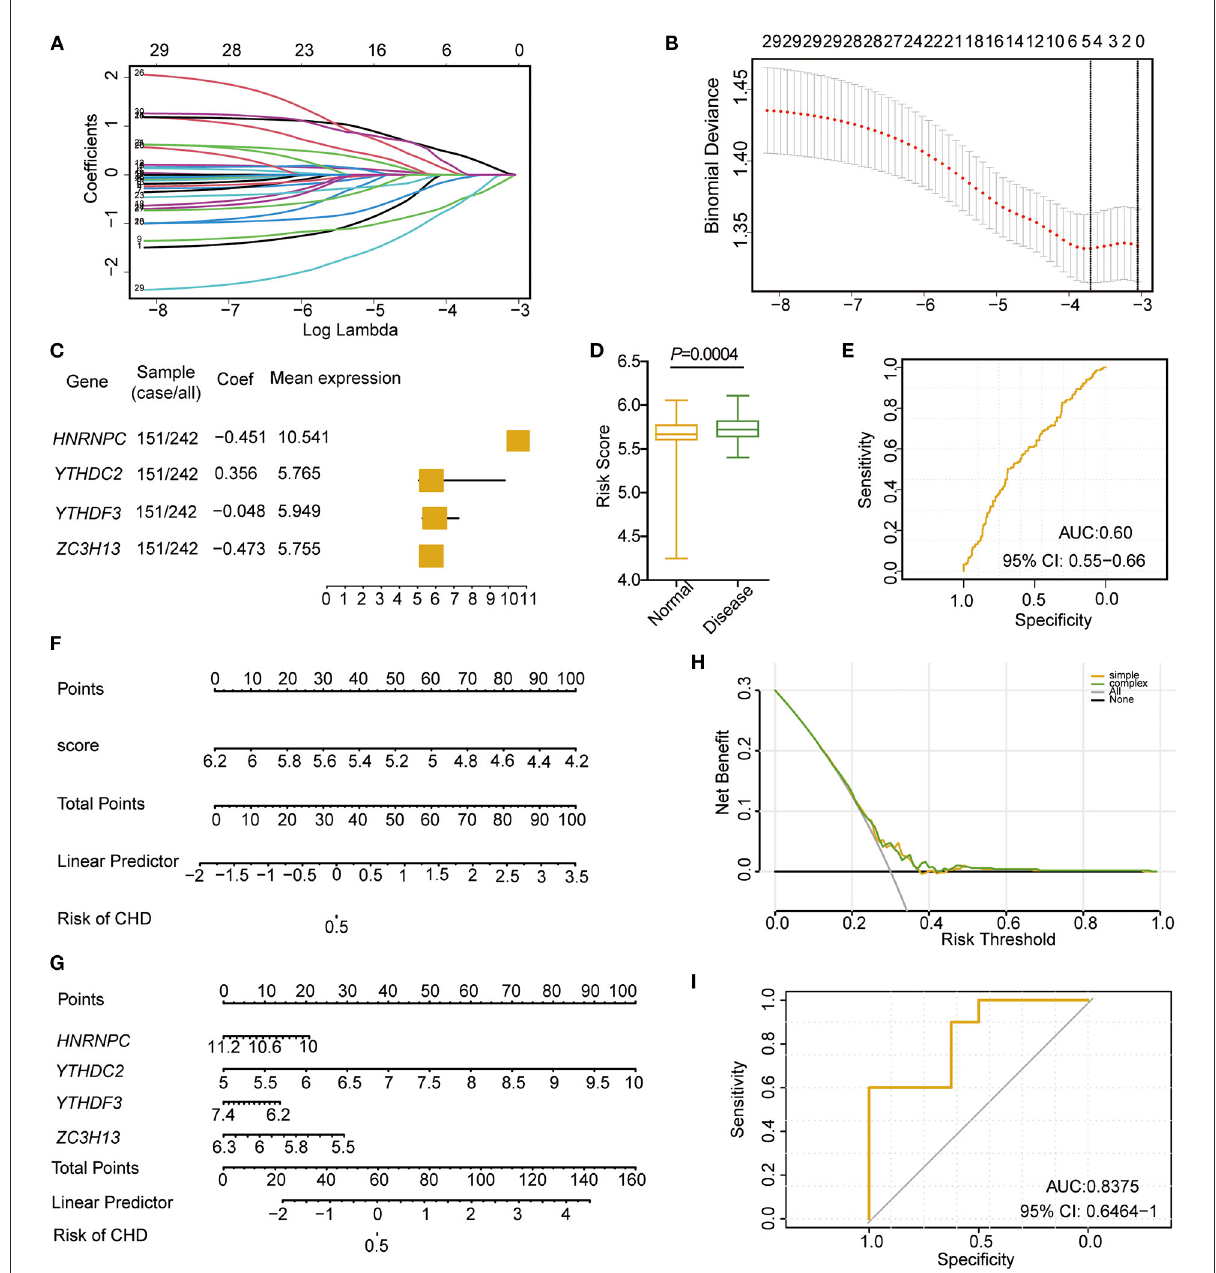
FIGURE3 Cox model construction based on m6A regulators in CHD. (A,B) LASSO regression to identify significant m6A RNA methylation modification genes related to CHD. (C) Forest diagram showing the four significant m6A regulators in patients with CHD. (D) The risk score between the disease and normal samples. (E) ROC curve of the four significances. (F) Nomogram of diagnostic scores for patients with CHD. (G) Nomogram of the four m6A regulator significance for the diagnosis of CHD. (H) PCA analysis of the nomogram model. (I) ROC curve of the cox model of the validation set